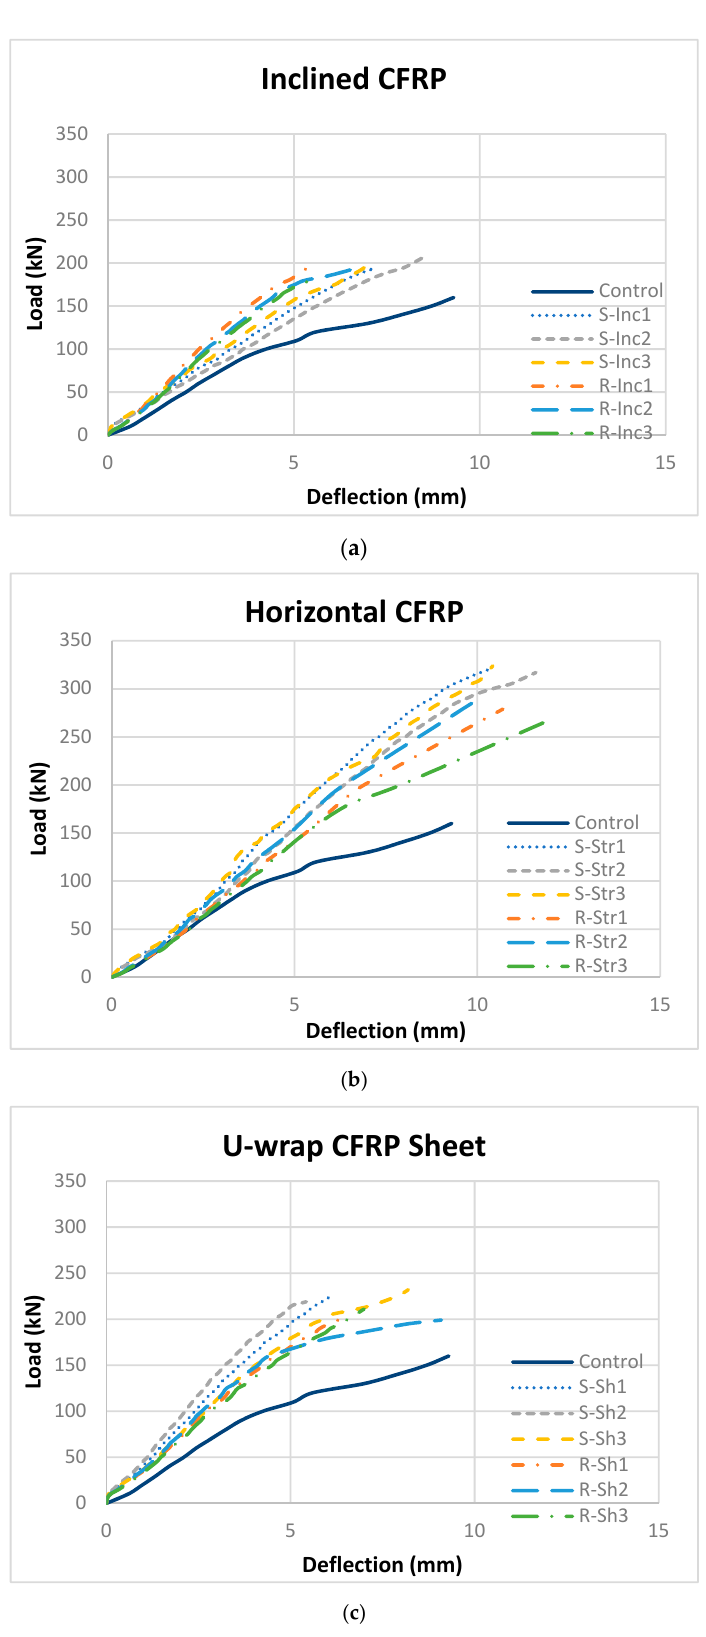
Figure 7. Experimental load–deflection curves for all beams: ( a ) inclined—group 2; ( b ) horizontal straight strips—group 2; ( c ) U-wrapped sheets—group 3.